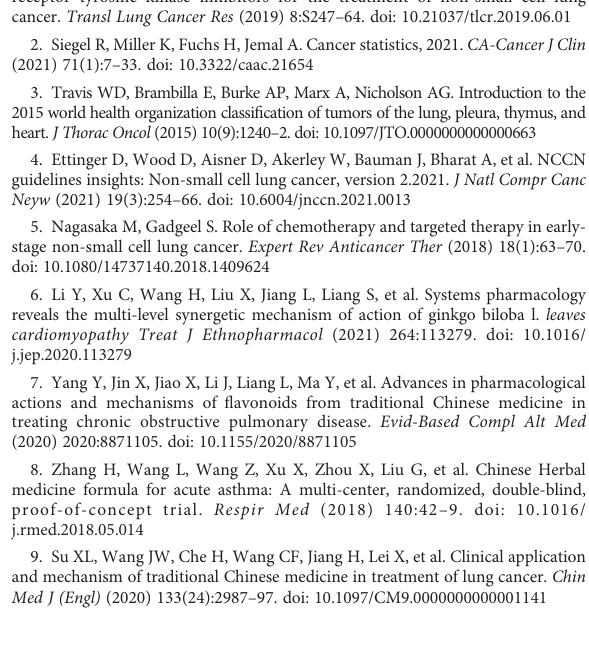
SUPPLEMENTARY FIGURE 1 Method of obtaining the Lycium barbarum (LB) extract and assays of its purity. SUPPLEMENTARY FIGURE 2 Original PPI network of the NSCLC targets of GQZ obtained from the STRING database. SUPPLEMENTARY FIGURE 3 PI3K/AKT signaling pathway adapted from the KEGG (ID: hsa04151). The targets in this pathway are shown in red. SUPPLEMENTARY FIGURE 4 Effects of LB on expression of BCL2 and Bim mRNAs. A549 cells were treated with LB (80 m g/ml) or vehicle for 24 h, and the levels of BCL2 and Bim mRNAs were analyzed by qRT-PCR, with GAPDH mRNA used as the internal control. SUPPLEMENTARY FIGURE 5 Effects of LB (10 mg/kg/day) on A549 xenograft tumor growth and mouse body weights. (A) Representative pictures of tumors in vivo . (B) Weights of xenografttumorsafter16daysofLBinjection. (C) Bodyweight-timecurve in mice. SUPPLEMENTARY FIGURE 6 Effects of LB on the expression level of PCNA protein in A549 xenograft tumors, as determined by western